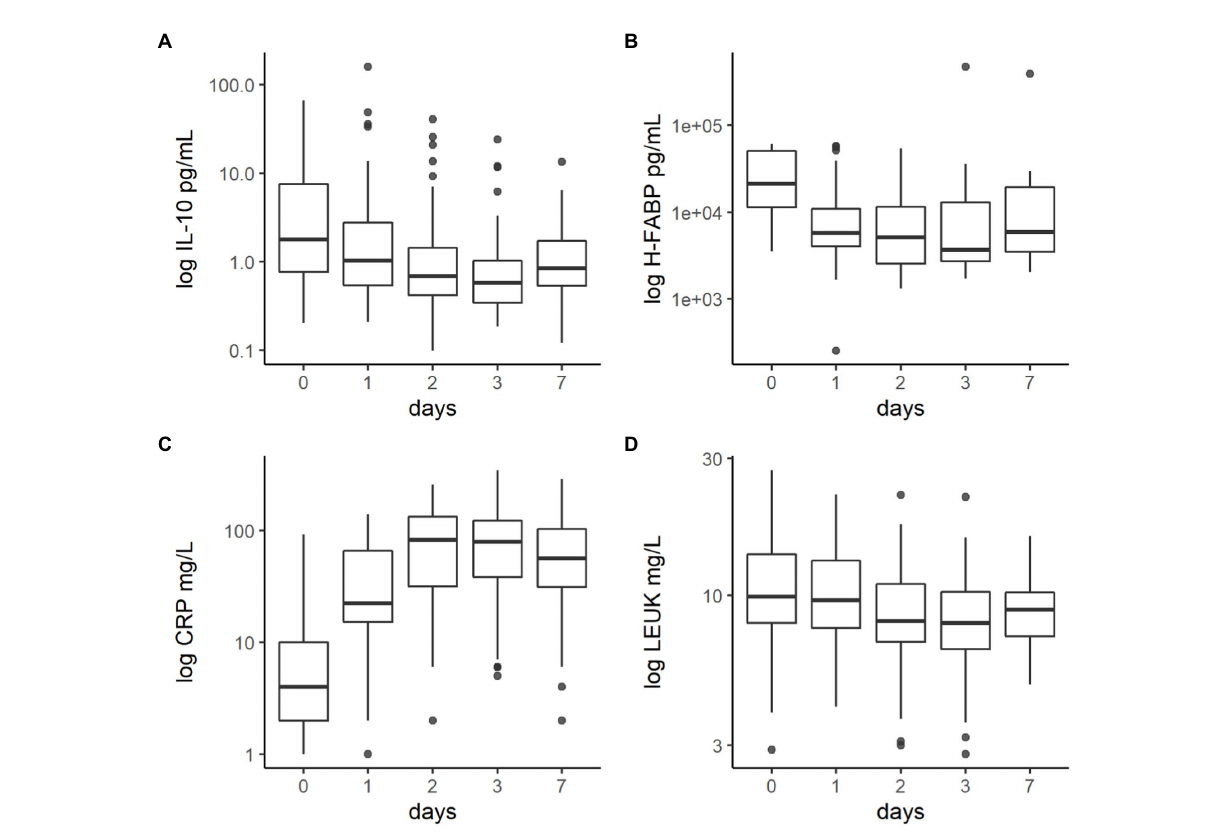
FIGURE 1 (A) The concentration of IL-10, (B) H-FABP, (C) CRP and (D) leuk during the first week after traumatic brain injury. The line that divides the box into two parts is median. The bottom of the box represents first quartile (Q1) and the top of the box represents third quartile (Q3). The lower whisker represents a minimum score (excluding outliers) and the upper whisker represents a maximum score (excluding